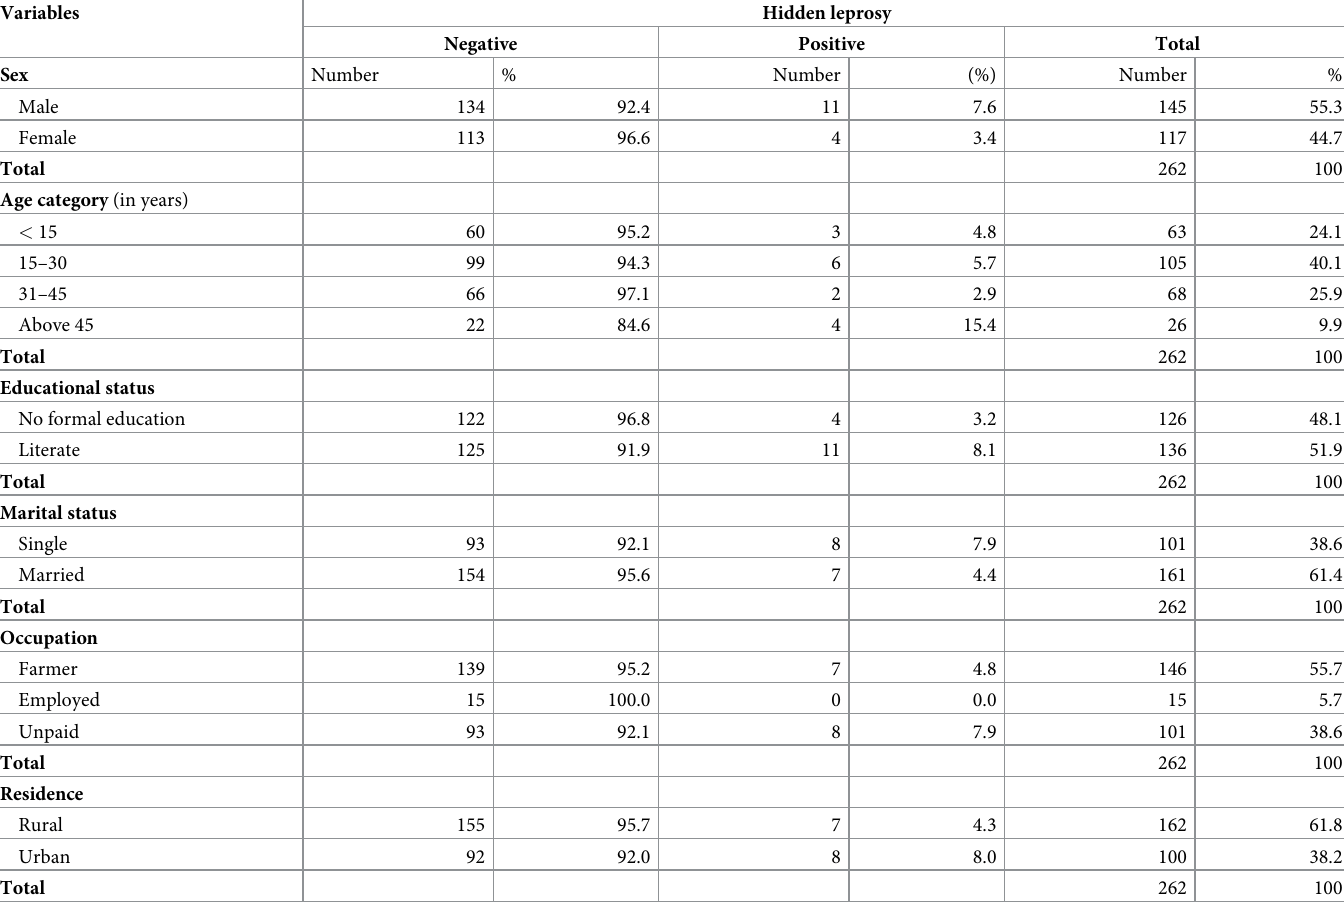
Table 1. Distribution of demographic and clinical condition among participants with or without leprosy in Fedis District, 2019(n = 262). Variables